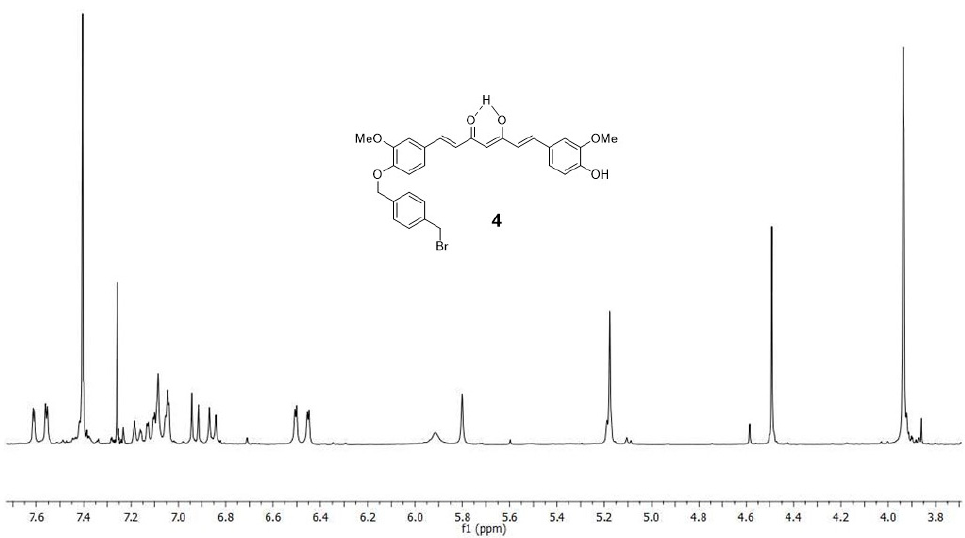
Figure 16. 1 H NMR spectrum of Compound 4 in CDCl 3 as solvent.